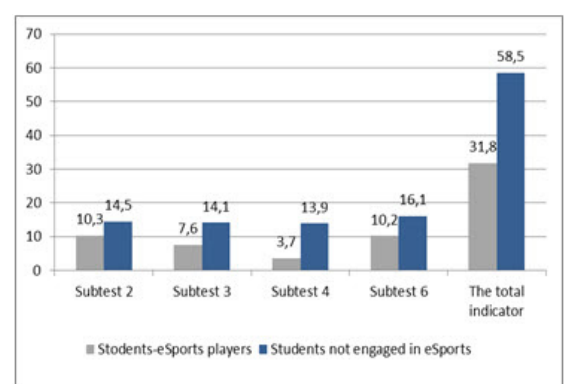
Figure 1. Results of diagnostics of the level of development of logical thinking of eS- ports students and non-eSports